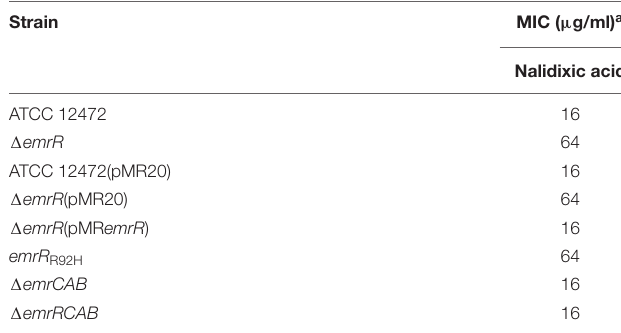
TABLE 2 | MIC of indicated strains using nalidixic